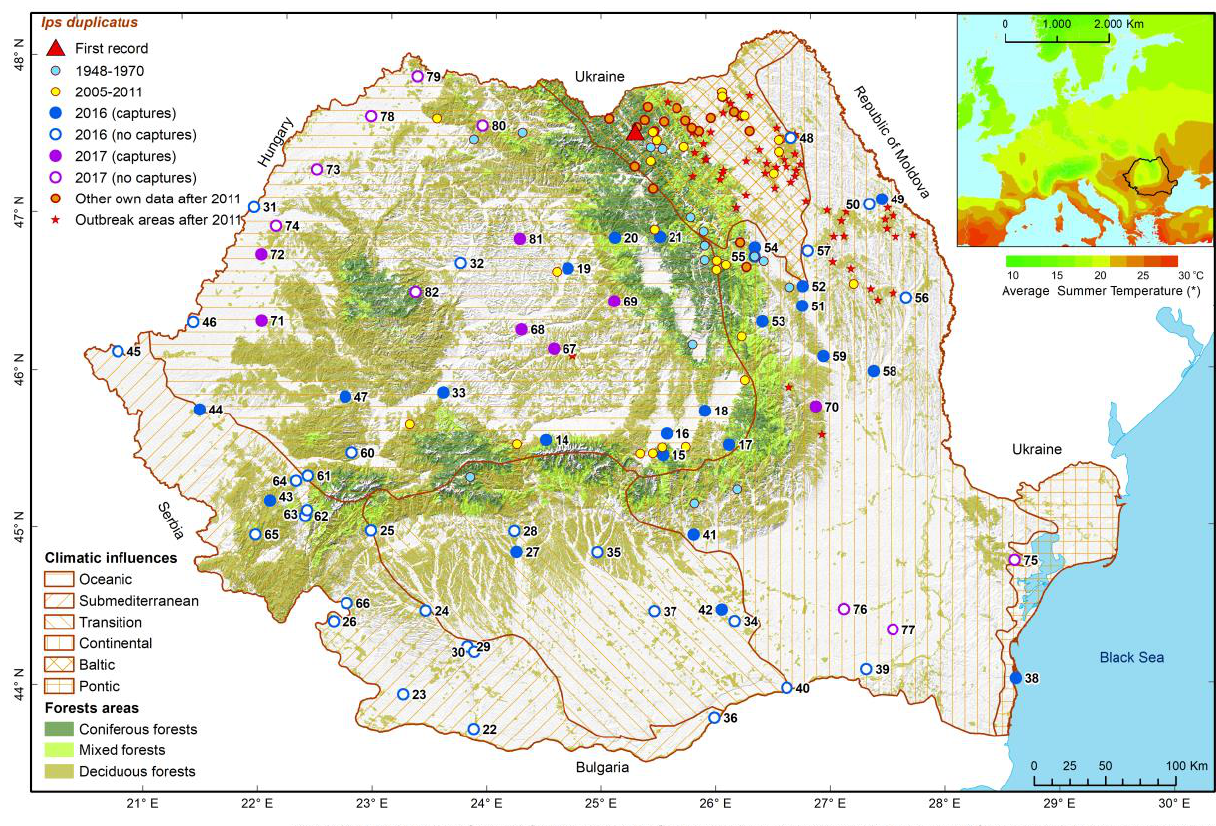
Figure 3. NBB capture variation according to tree stand composition.